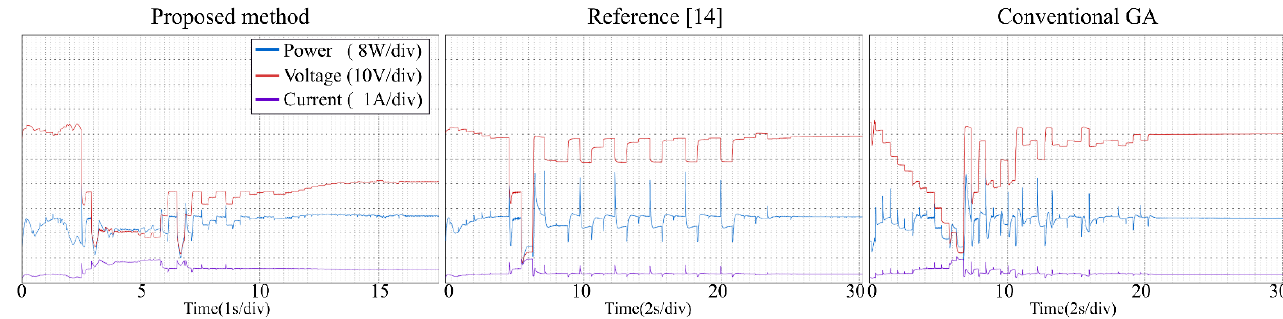
Figure 18. Tracking process—Pattern 6.